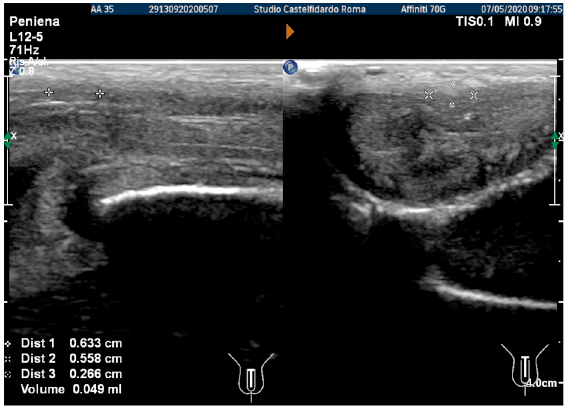
Figure 2. Ultrasonography of the penis after the 1st therapy cycle (longitudinal and axial views).